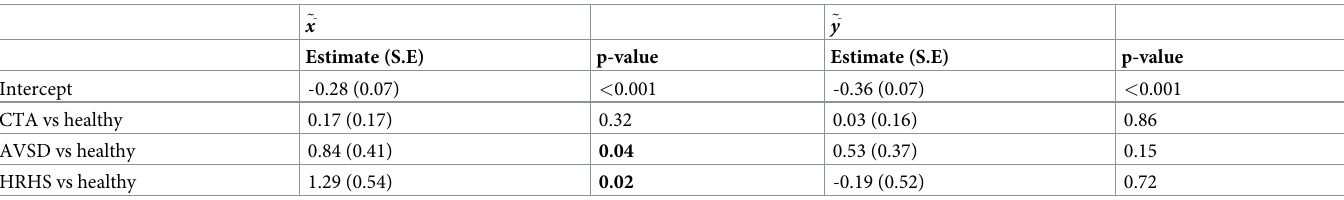
Table 4. Difference in normalized ( ~ x ~ ; ~ y ~ ) coordinates between the healthy control group and each CHD subgroup. ~ x ~ ~ y ~ Estimate (S.E) p-value Estimate (S.E) p-value Intercept -0.28 (0.07) < 0.001 -0.36 (0.07) < 0.001 CTA vs healthy 0.17 (0.17) 0.32 0.03 (0.16) 0.86 AVSD vs healthy 0.84 (0.41) 0.04 0.53 (0.37) 0.15 HRHS vs healthy 1.29 (0.54) 0.02 -0.19 (0.52)